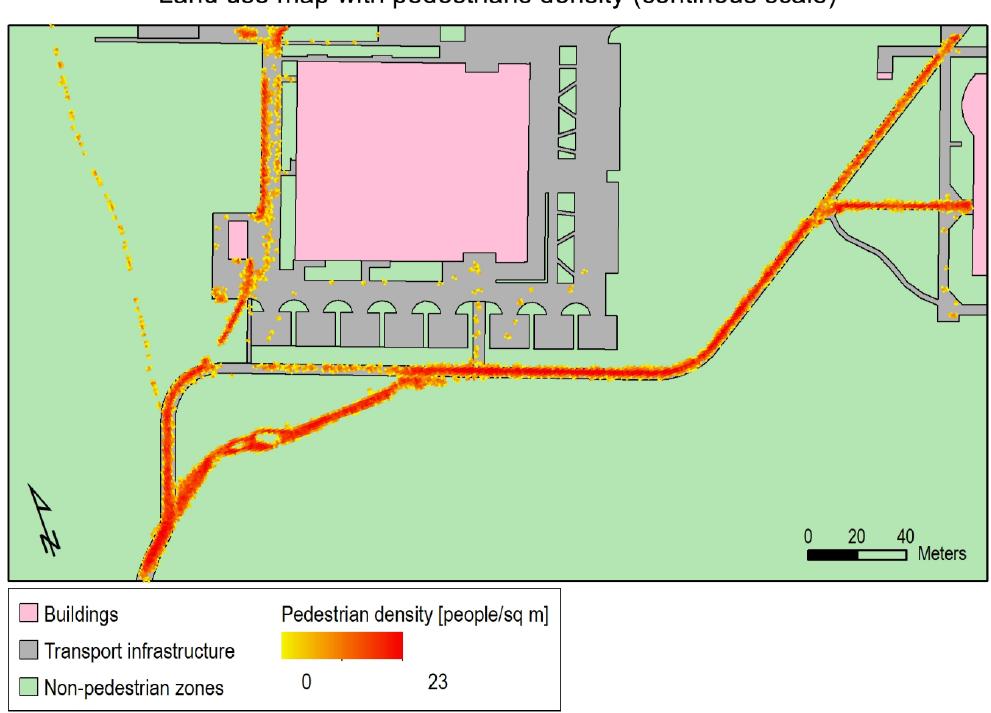
Figure 9. The map of pedestrian density in the research area (continuous scale): the chorochromatic method (qualitative data).